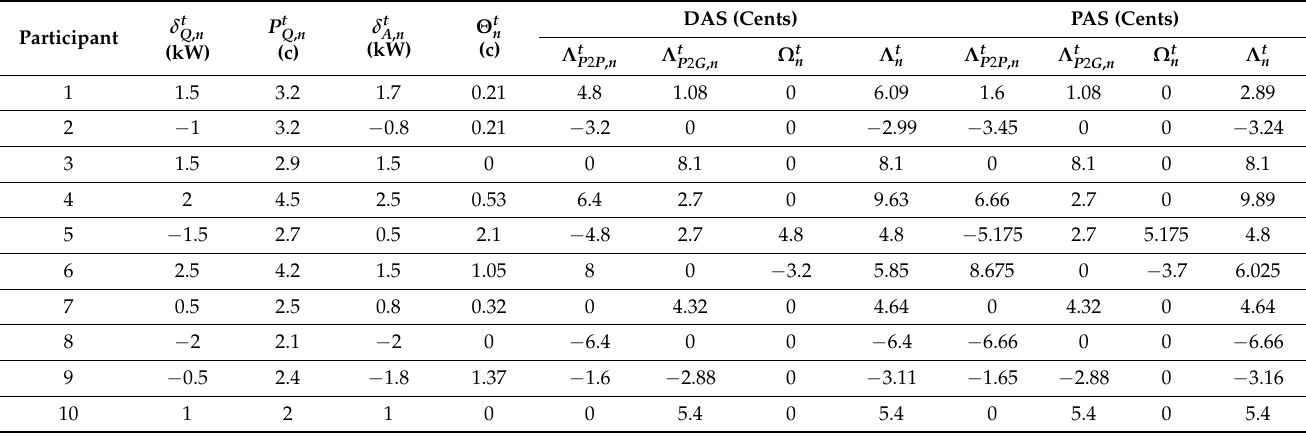
Table 4. DAS and PAS-based penalty analysis for participants’